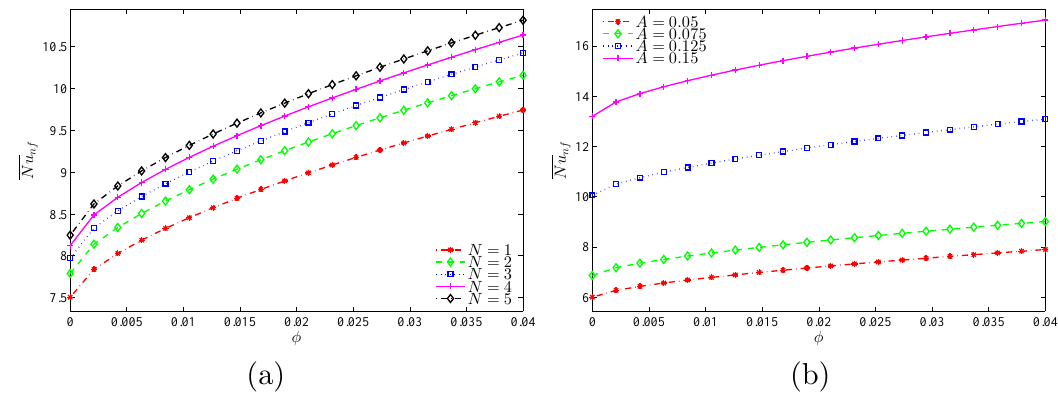
Figure 12. Variation of the average Nusselt number with φ for different ( a ) N and ( b ) A at Ra = 10 6 .